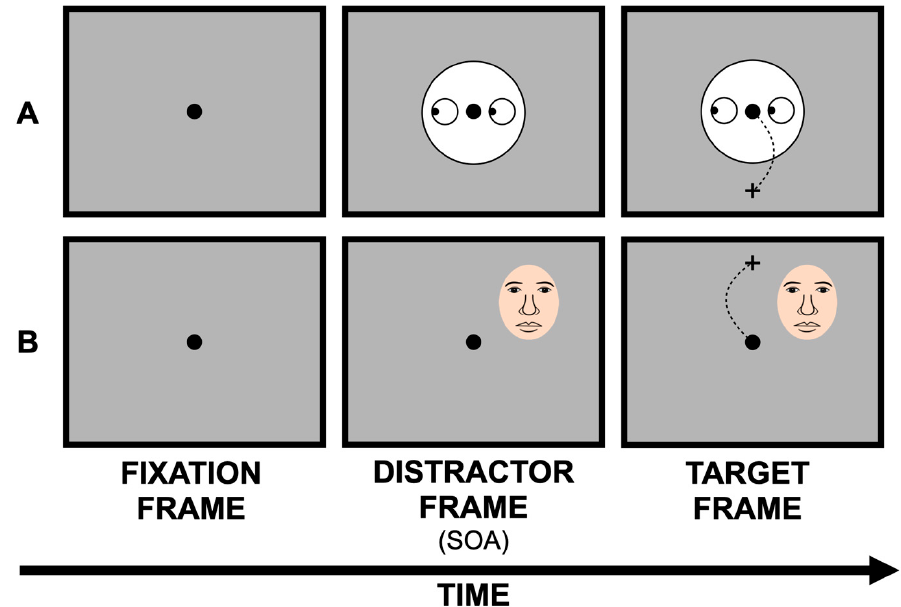
Figure 1. Examples of the two main paradigms used to explore the impact of facial stimuli on saccadic curvatures. A central fixation spot is typically followed by a distracting face and a symbolic target stimulus. In ( A ), a central distracting face with its eye gaze averted leftwards is presented, while ( B ) shows a peripheral distracting face with a direct gaze. The dotted lines represent potential saccadic trajectories. Stimuli are not drawn to scale. SOA = stimulus onset asynchrony.